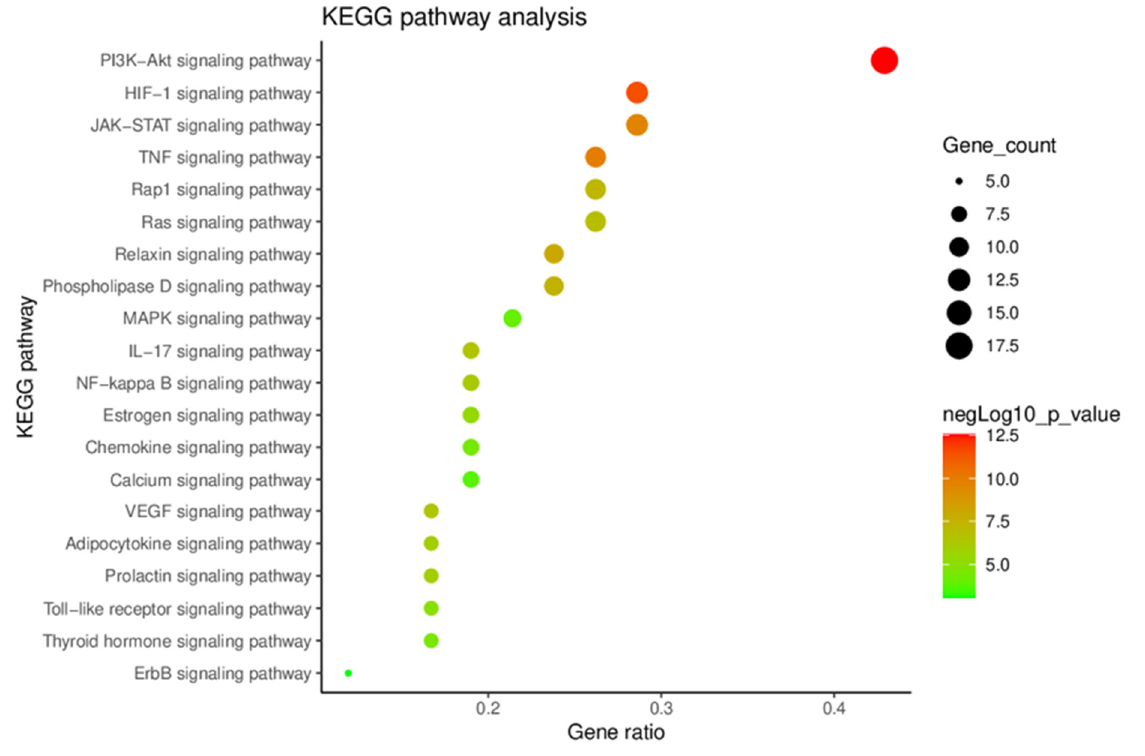
Figure 3. A bubble chart of KEGG signaling pathway enrichment analysis.